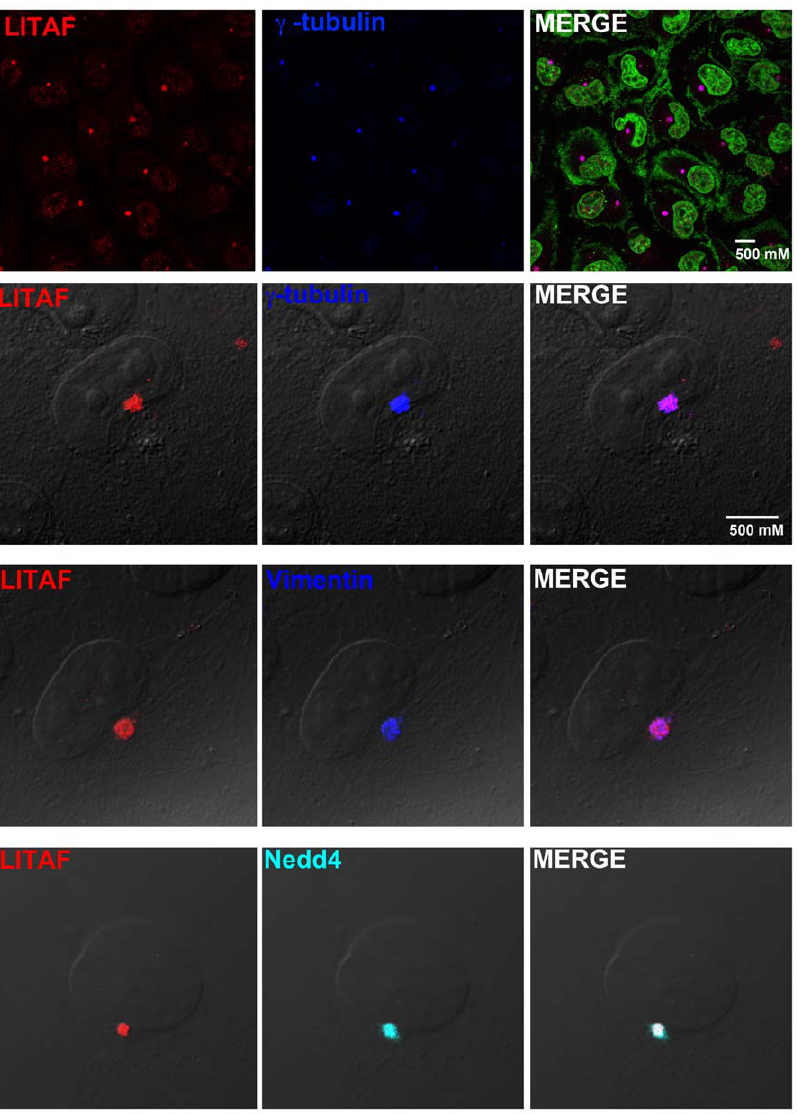
Figure 1. Endogenous LITAF accumulates in aggresomes. In order to detect endogenous LITAF, BGMK cells were fixed and indirect immunofluorescence was performed. Anti-LITAF antibodies were used to detect endogenous LITAF (red), anti-Nedd4 antibodies were used to detect Nedd4 (cyan), and anti-vimentin or anti- c -tubulin antibodies were visualized (blue) to determine localization of LITAF. Nuclei were visualized using differential interference contrast (DIC) or ToPro (green). All images were taken using a laser scanning confocal microscope.